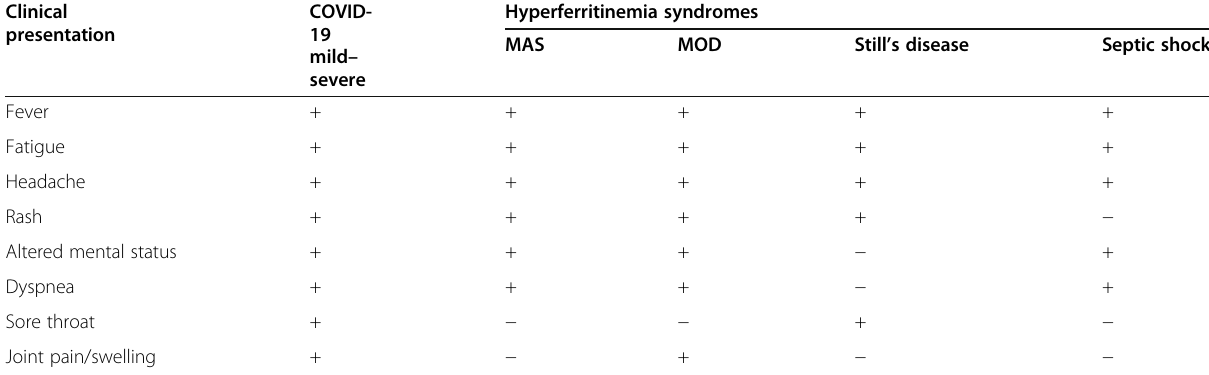
Table 1 Clinical presentation of COVID-19 and hyperferritinemia-associated syndromes Clinical presentation